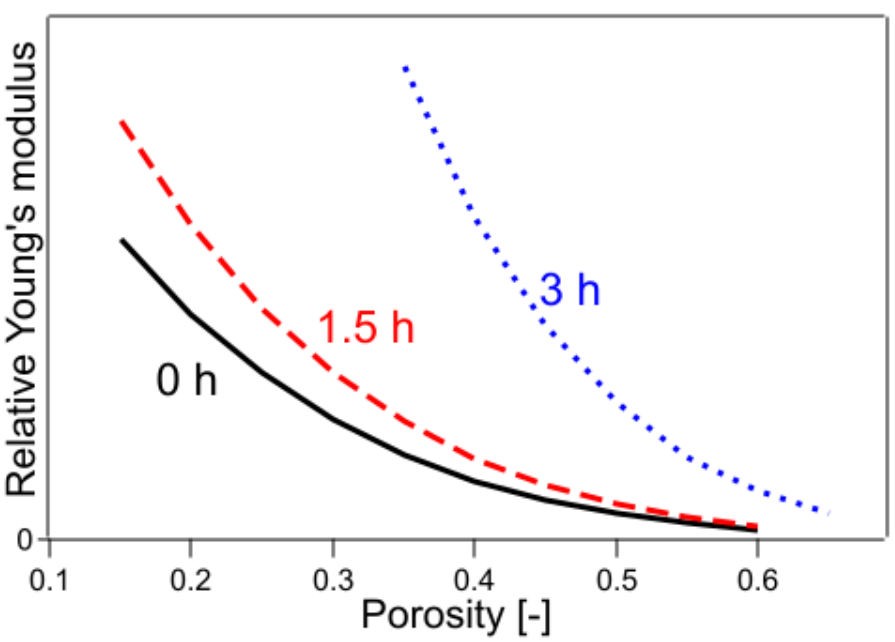
Figure 8. Young’s modulus fitted by Equations (17)–(19). The numbers in the figure indicate the heating time of the